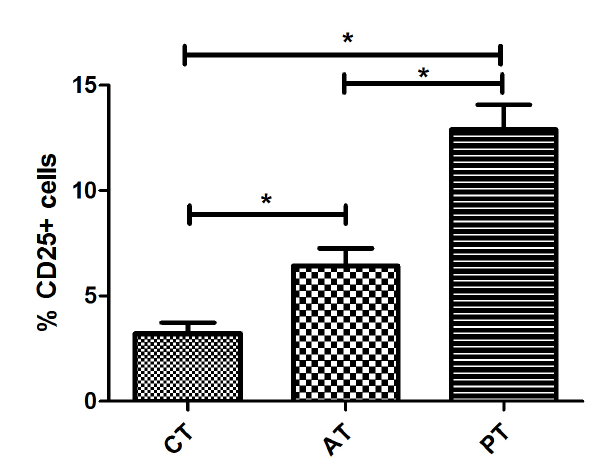
Figure 3. Proportion of regulatory T cells (CD25 + ) in the peripheral blood of controls (CT), patients with active lesion (AT), and patients after chemotherapy (PT). Differences between groups were considered significant when p < 0.05 and are indicated by asterisks